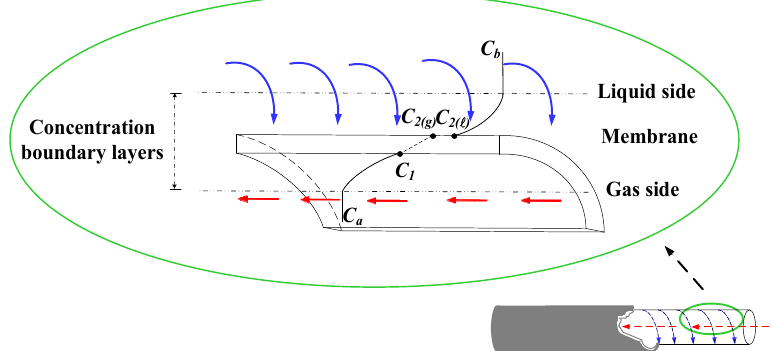
Figure 3. Schematic concentration profiles and boundary layers of a spiral wired annulus channel.